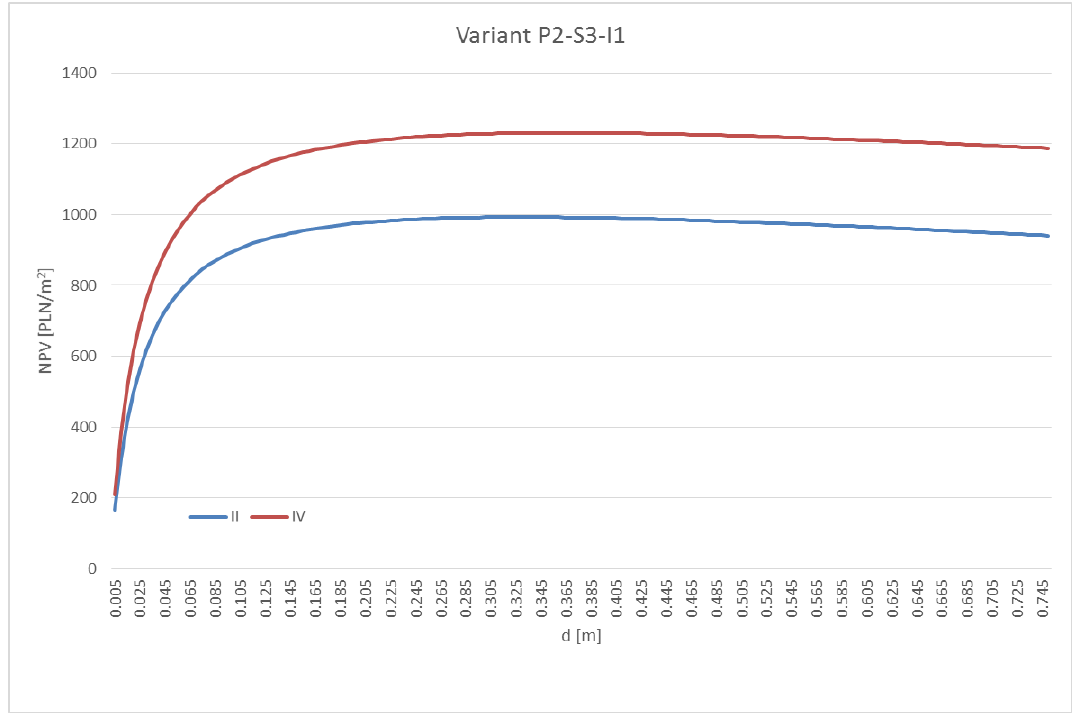
Figure 5. NPV values depending on the thickness of the thermal insulation for variant P2-S3-I1 in zones II and IV.